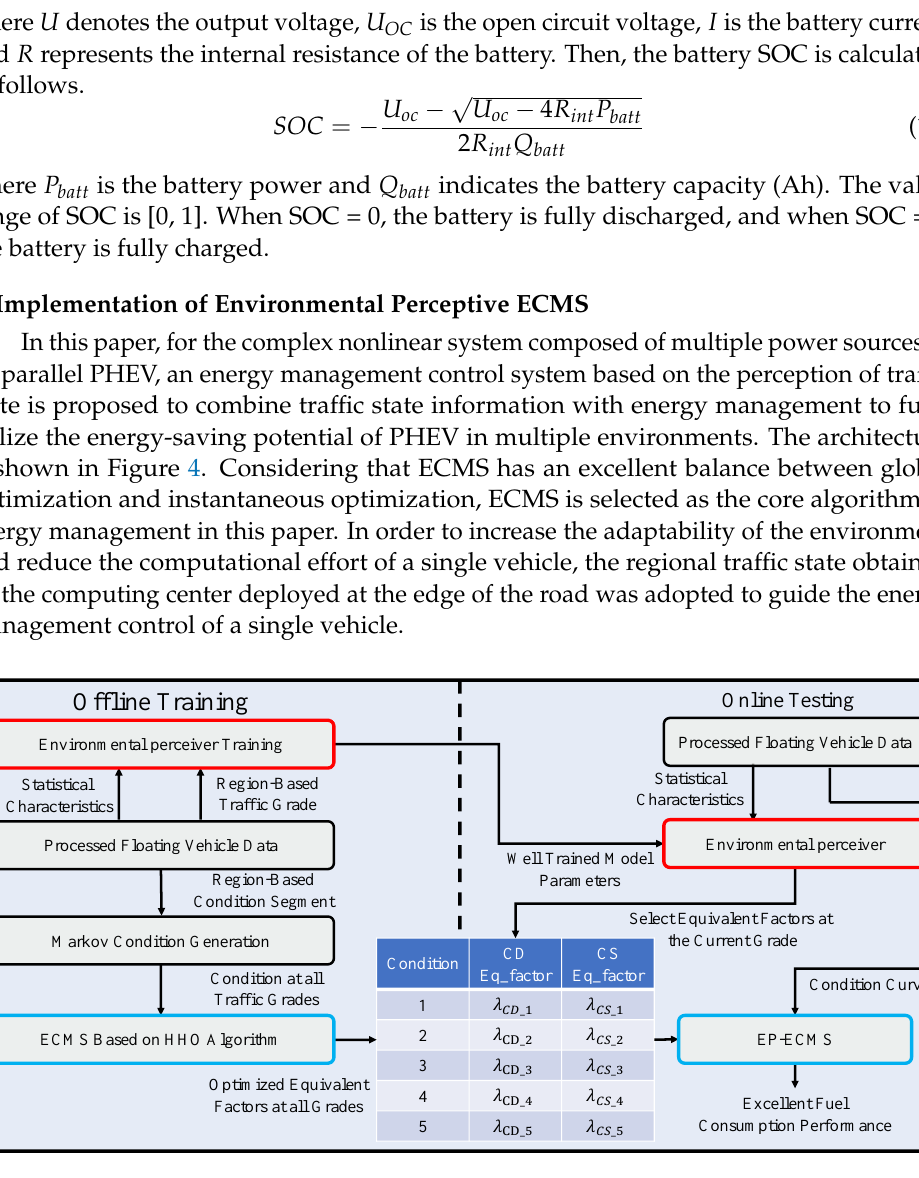
Figure 4. The architecture of